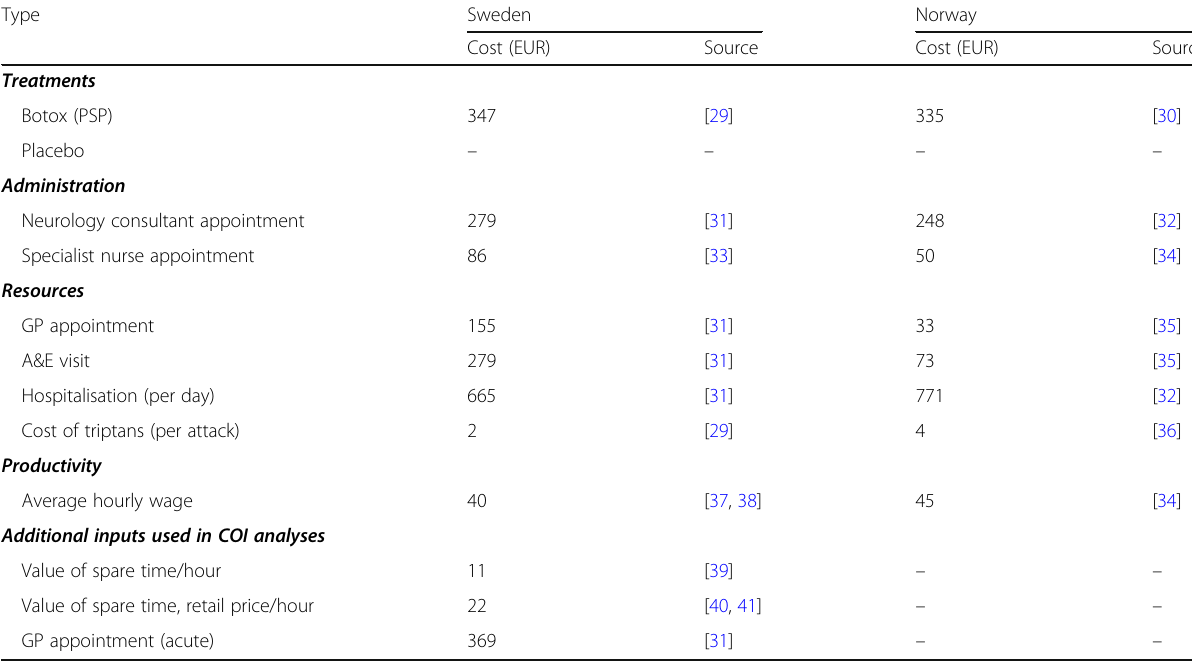
Table 1 Unit costs (EUR